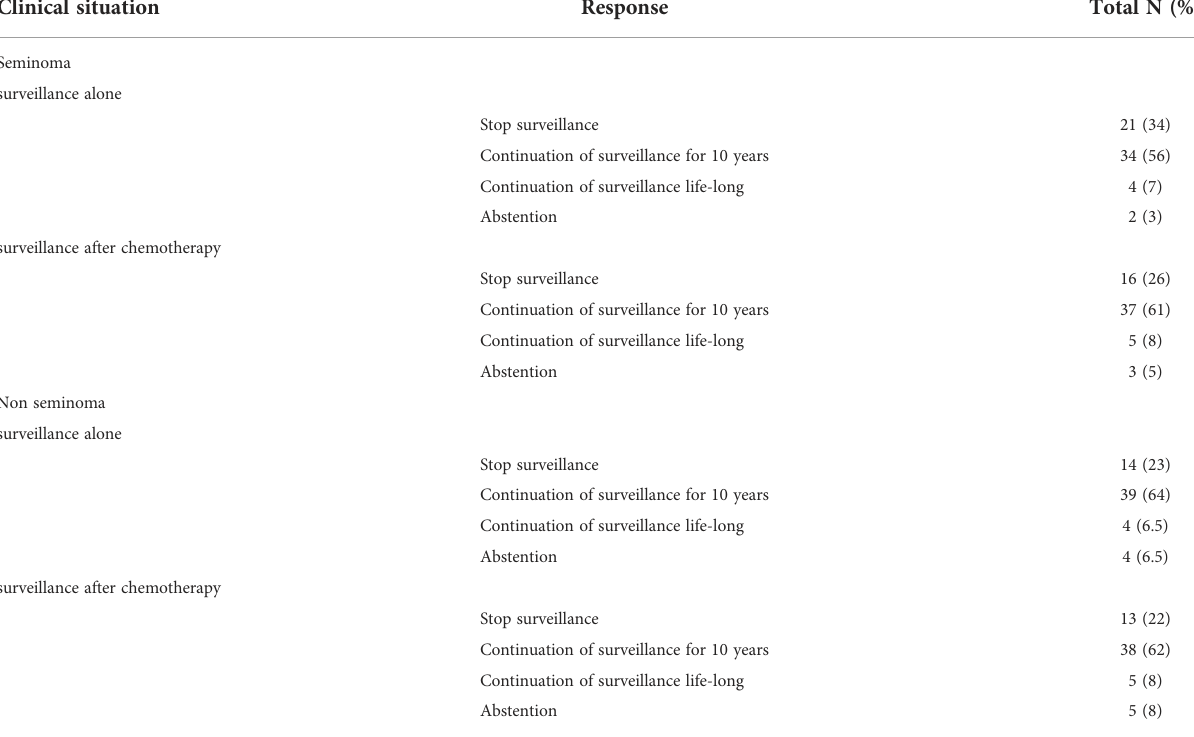
TABLE 4 Current practice of respondents after the 5 th year of